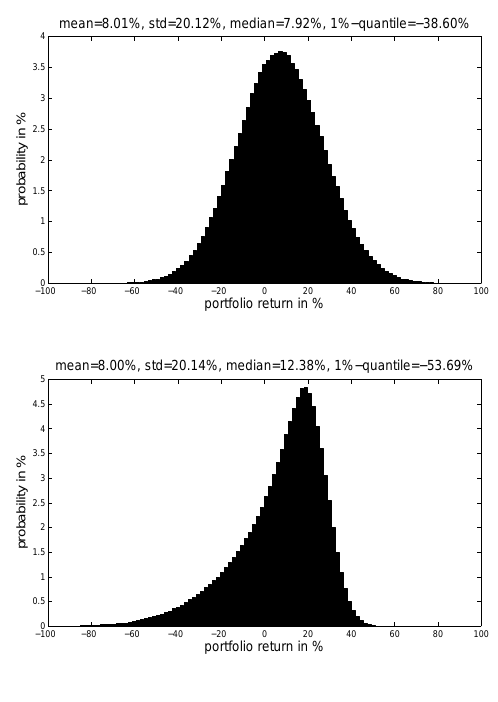
Figure 10: Visualization of the probability distribution of the MVP for d = 20 . Top: model R (1) . Bottom: model R (2) .